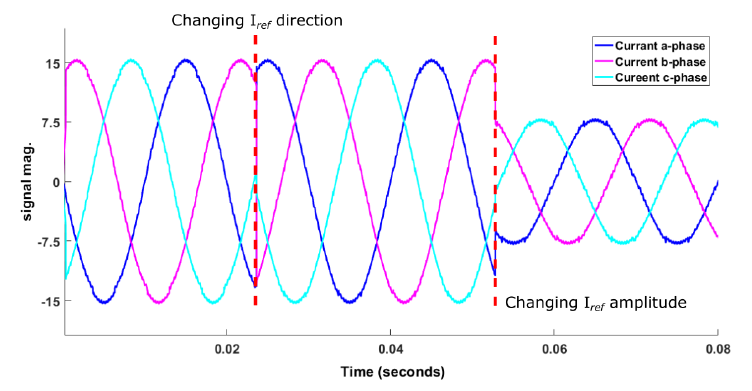
Figure 15. AHMMC current waveform.